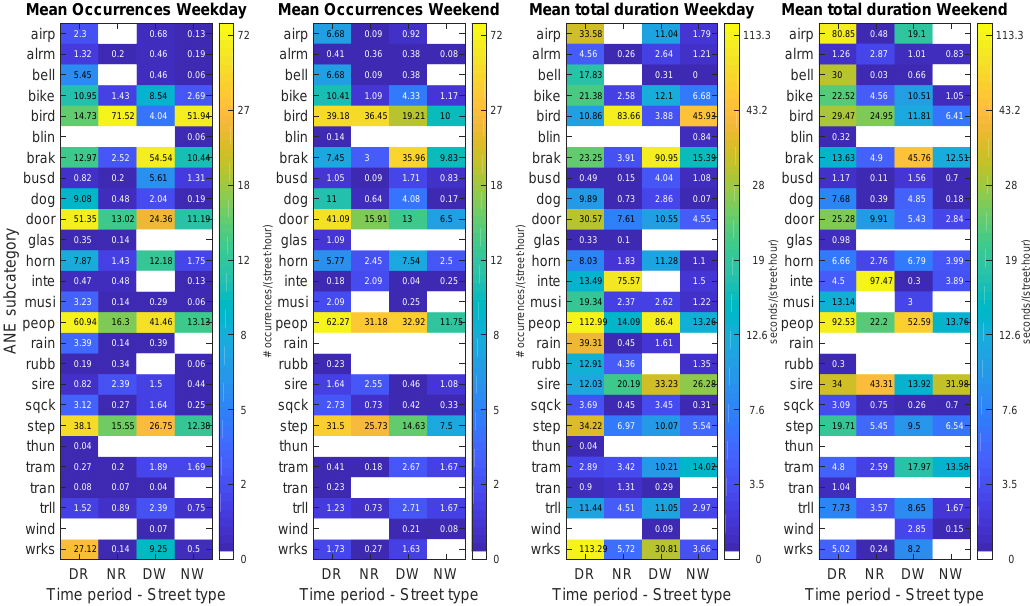
Figure 8. Results of the day–night and narrow–wide pairs analysis ( P RW weekday and weekend days for the following ANE features: mean number of occurrences per street and hour (two leftmost subfigures) and total duration per street and hour (two rightmost figures). Each subfigure shows the distribution of the corresponding ANE feature in terms of ANE subcategory and the pair street type and time period.